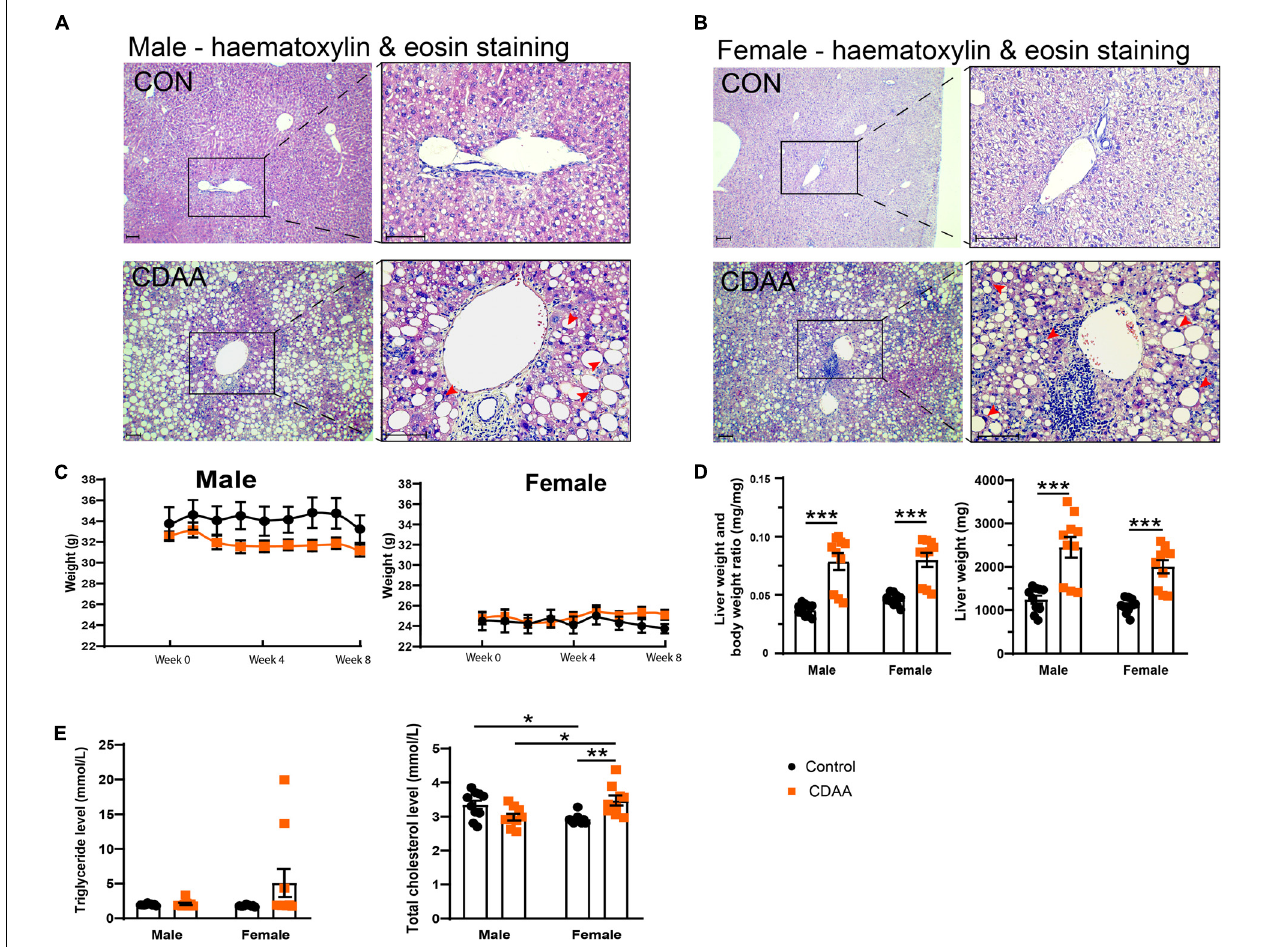
FIGURE 2 | Hepatic injury in the mouse CDAA NASH model. Histological assessment of hepatic pathological alterations on hematoxylin-eosin stained sections in female and male mice (A,B) . Weekly body weight alterations of male and female mice, respectively (C) . Assessment of liver enlargement by liver weight and liver weight to body weight ratio (mg · mg-1) (D) . Serum triglyceride and total cholesterol levels (E) . Scale bar indicates 100 µ m. Results are shown as mean ± standard error of mean (SEM). * P < 0.05 was considered significant, ** P < 0.01 was considered significant, *** P < 0.001 was considered